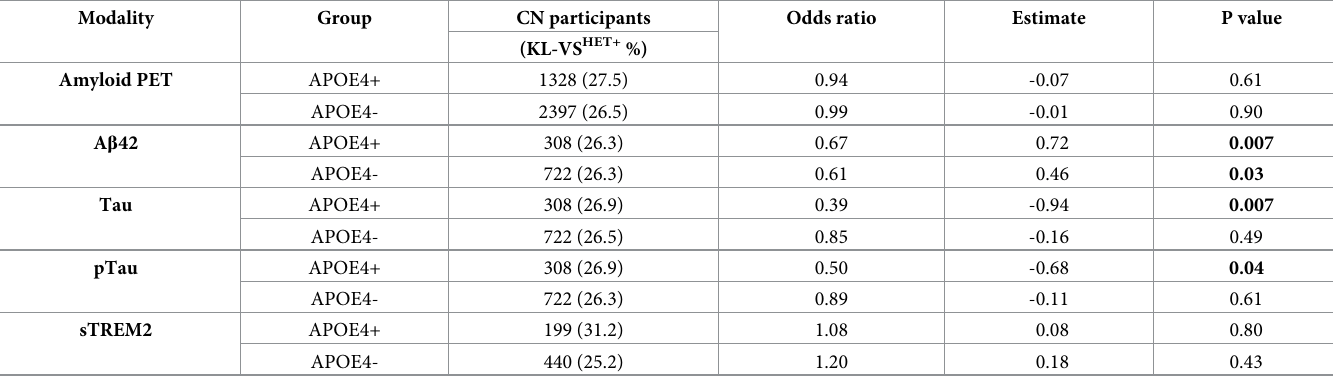
Table 2. Genetic association of KL-VS HET+ with AD endophenotypes in cognitively normal participants aged 60–80 years, stratified by APOE ε 4 status.